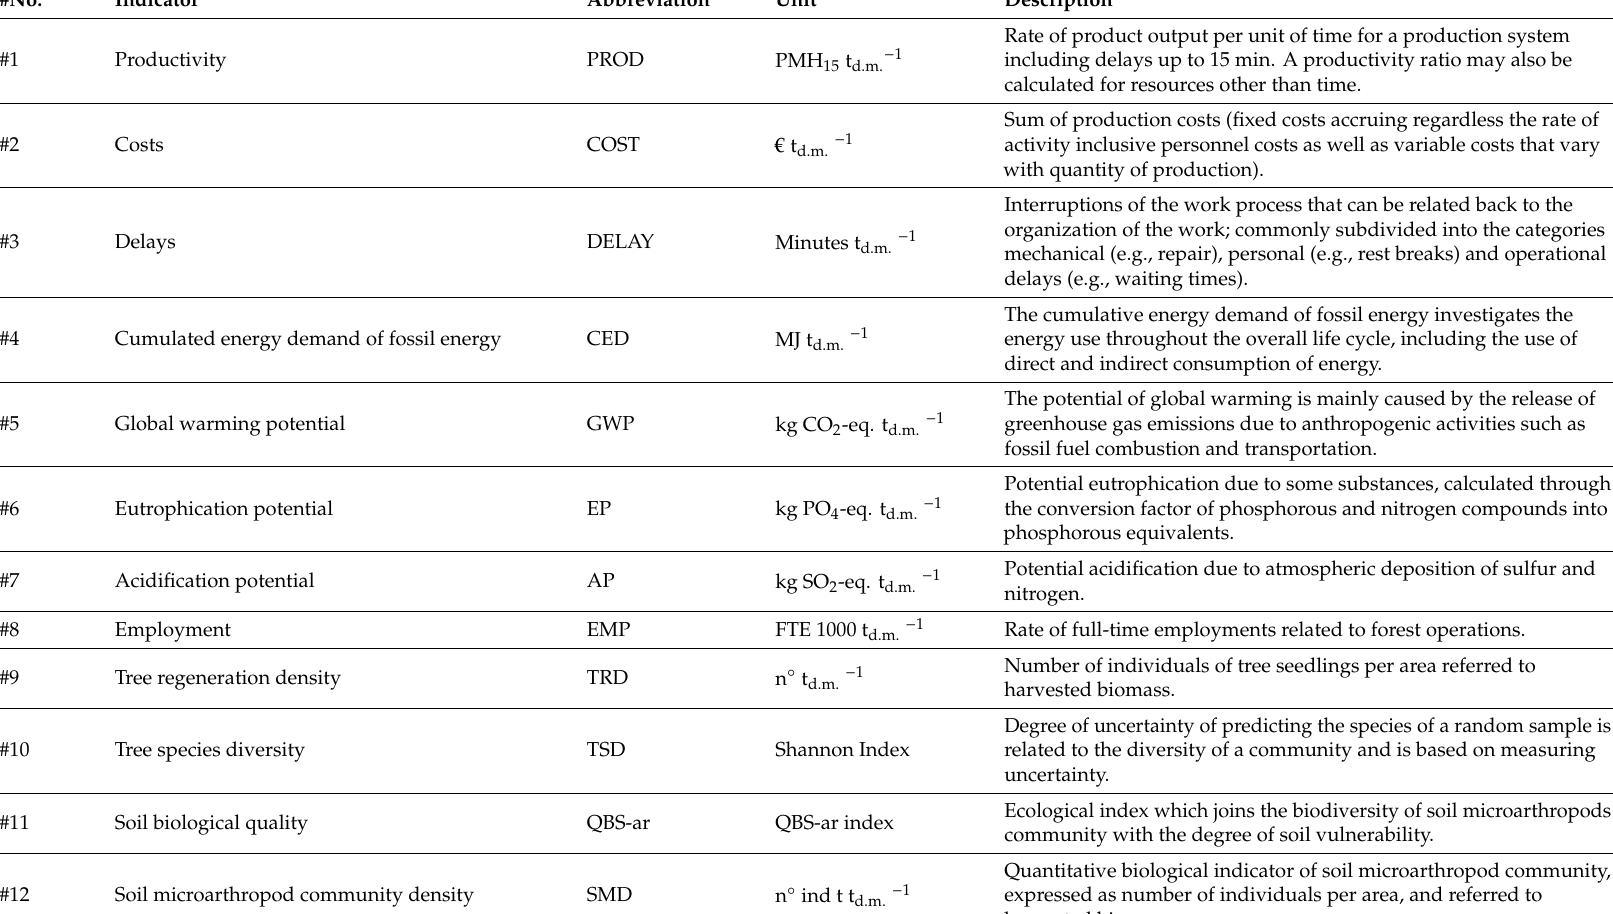
Table 2. Applied sustainability